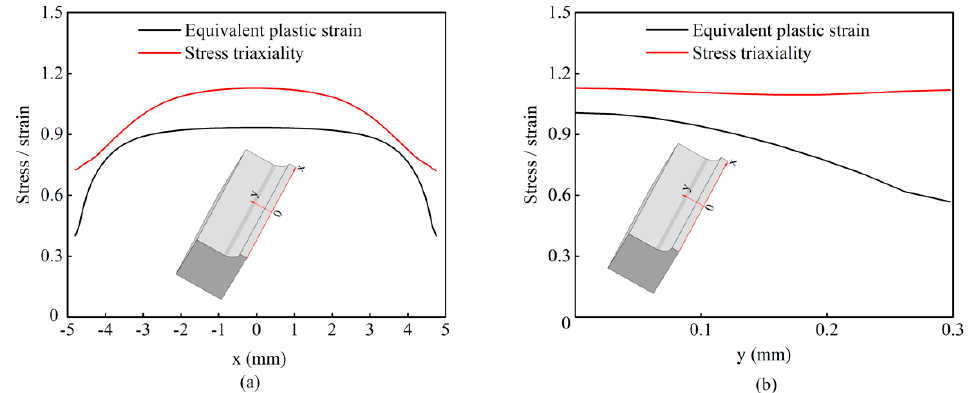
Figure 16. Distributions of equivalent plastic strain and stress triaxiality along the specified paths: ( a ) x-axis; ( b ) y-axis.